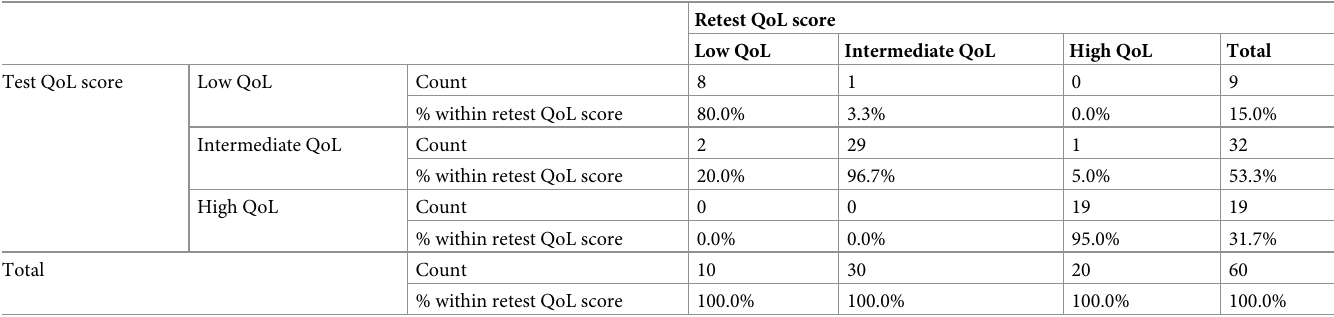
Table 3. Cross tabulation between test and retest QoL scores in patients with anal fistula.